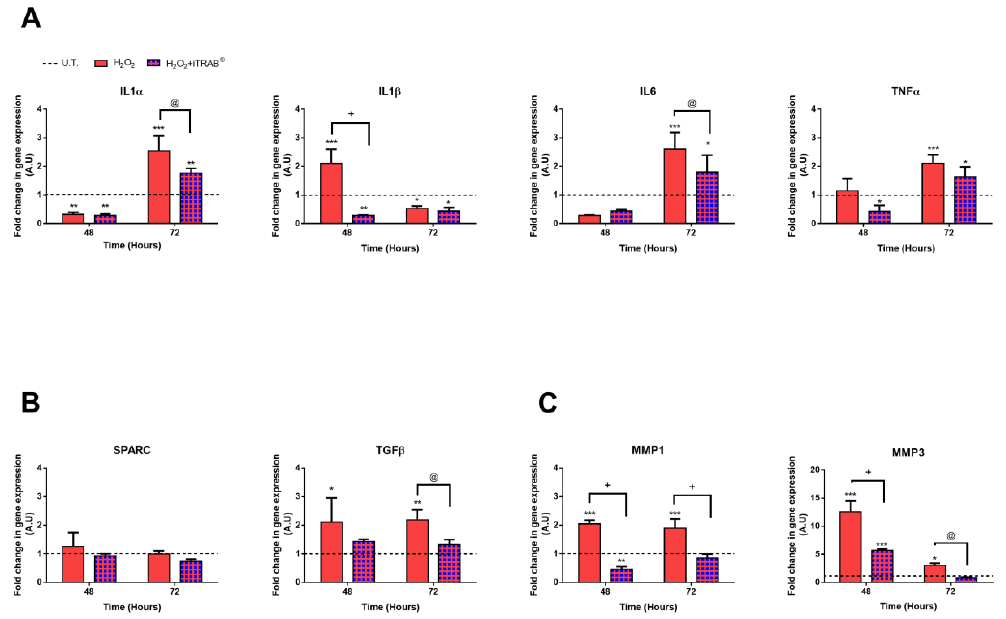
Figure 4. qPCR Analysis.Gene expression analysis was performed on 3D-human trabecular meshwork cells (HTMCs)HTMCs after the 2nd and 3rdexposure of 500 µ M H 2 O 2 only and co-treatment with iTRAB ® and 500 µ M H 2 O 2 . ( A ) IL1 α , IL1 β , IL6, TNF α ; ( B ) TGF β and SPARC; ( C ) MMP1 and MMP3. Data are expressed as fold-increases relative to untreated cultures at the same end-point and normalized to HPRT1 housekeeping gene expression. The black dotted line represents the gene level of untreated 3D HTMCs for each gene examined. Each bar represents the mean ± standard deviation (SD) of three independent experiments performed in triplicate. ***, **, * treated 3D HTMCs vs. untreated (U.T.); + , @ H + iTRAB-treated 3D HTMC. *** /+ p < 0.001; ** p < 0.01; * / @ p < 0.05 (Two-way 2 O 2 -treated vs. H 2 O 2 ANOVA followed by